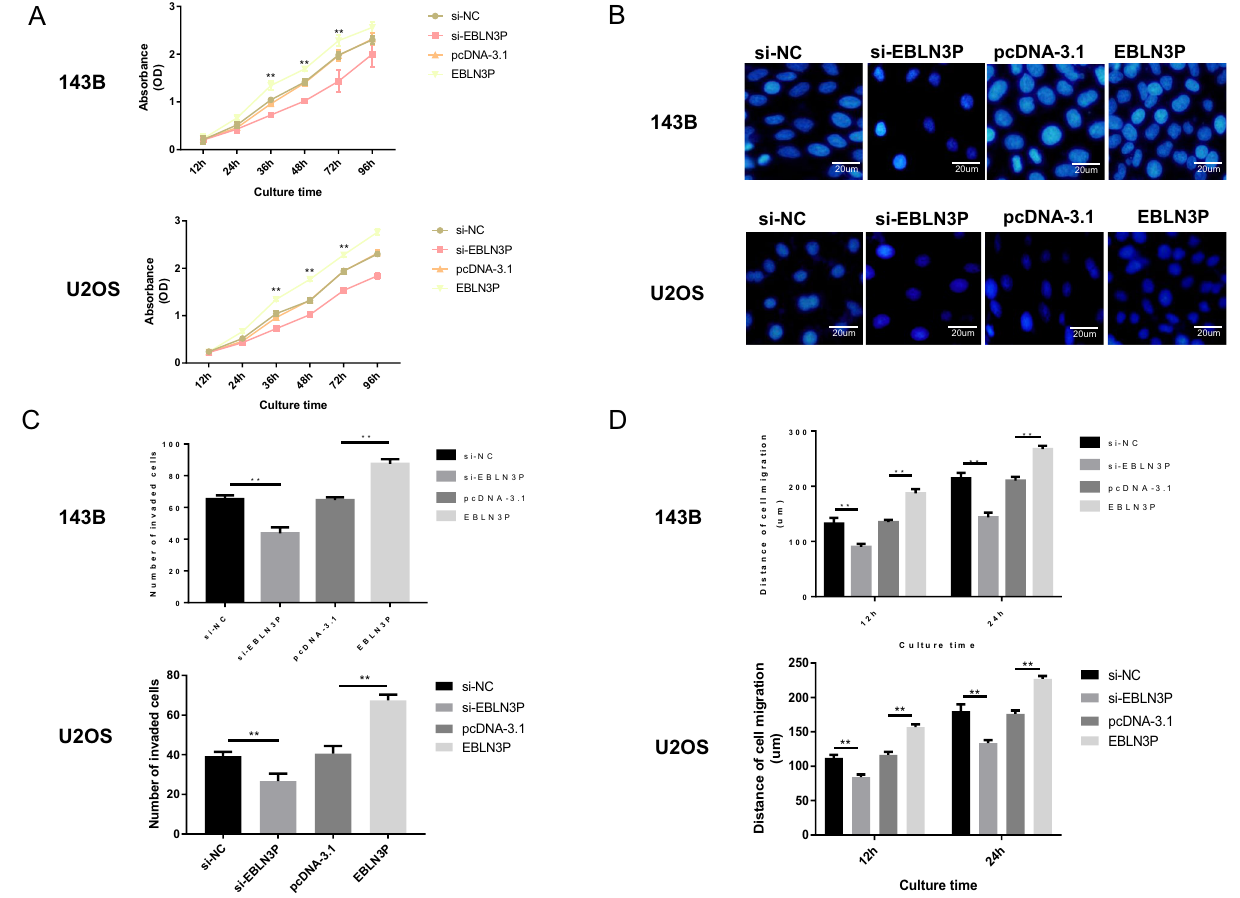
Figure 4. EBLN3P knockdown inhibited the proliferation, migration and invasion of osteosarcoma cells in vitro. ( A ) Cell proliferation was tested by Cell Counting Kit-8 assay. ( B ) Cell invasion were detected by Transwell assay. ( C ) The numbers of the invaded cells. ( D ) Cell migration was detected by the wound healing assay. EBLN3P endogenous bornavirus-like